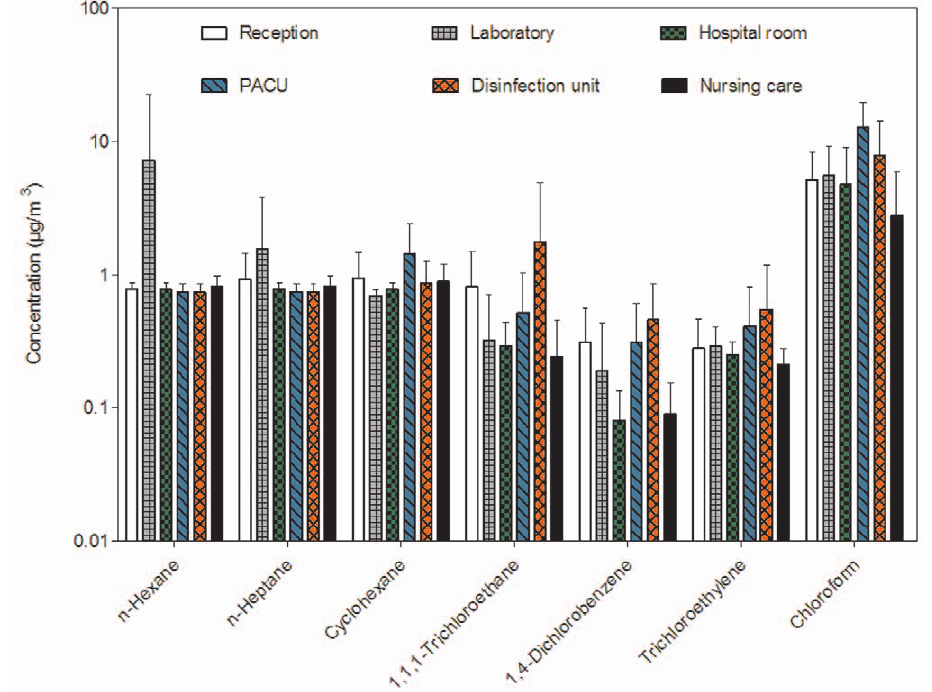
Figure 2. Comparison of aliphatic and halogenated hydrocarbons concentrations (mean ± SD on a logarithmic scale) in the six sampling sites.